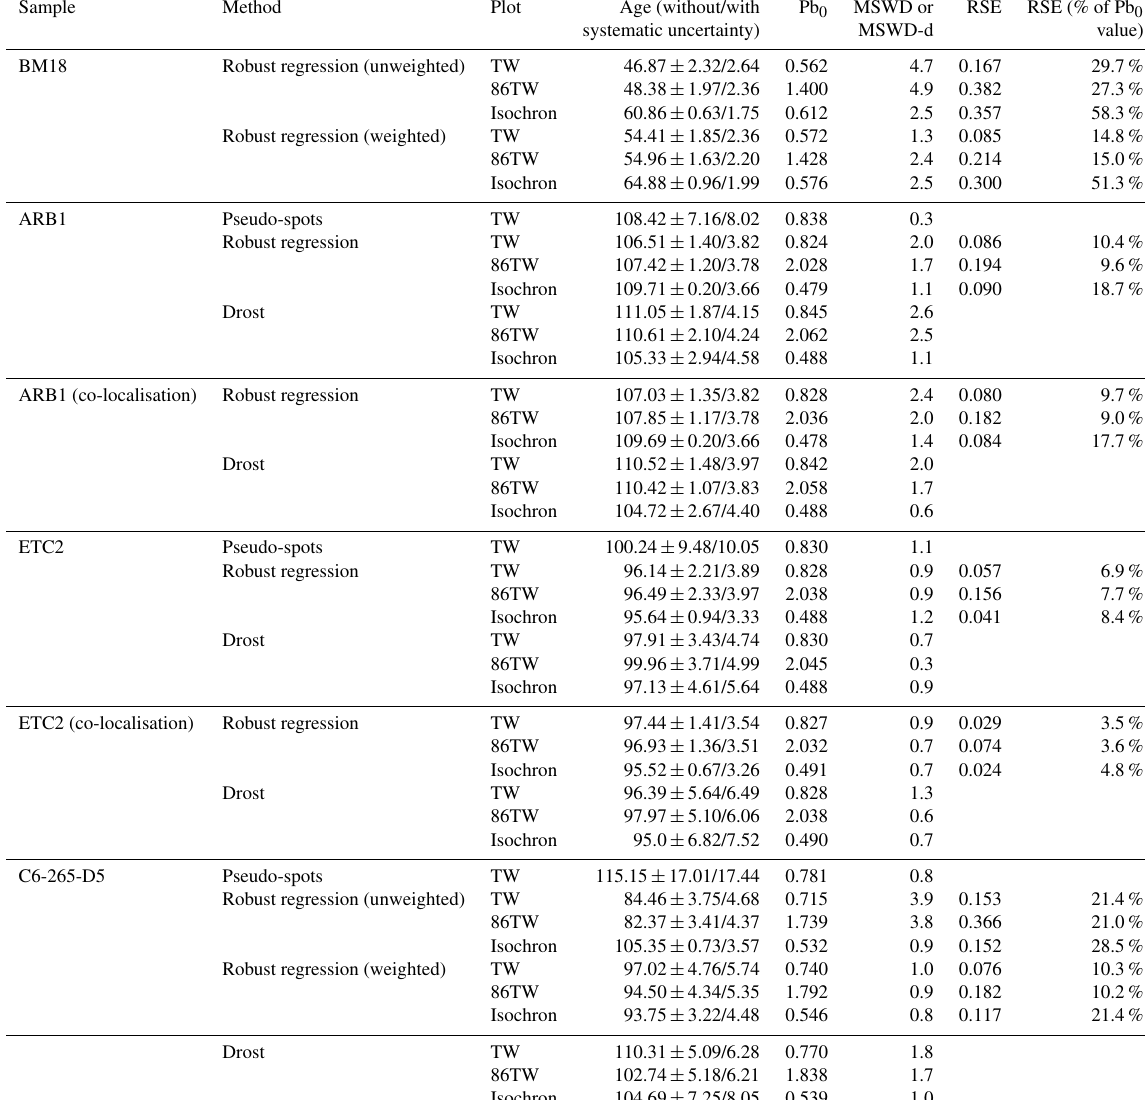
ting the isotopic maps in pseudo-spots allows for the calcu- lation of ages of 61.3 ± 3.0 Ma (Fig. 3e) and 61.7 ± 3.0 Ma (Fig. S3), with a MSWD of 0.1 and 0.4 respectively, which are values that are fully consistent with the ages obtained with the robust regressions from the entire maps (Table 1). The latter vary between 60.7 ± 2.0 Ma and 61.8 ± 2.2 Ma ac- cording to the diagrams considered (Fig. 3c, d; only TW concordia plots shown). They are identical within the limits of uncertainty to the values obtained with LA-ICP-MS spot analysis, both by Beaudoin et al. (2018) and in our laboratory (63.2 ± 2.2 and 61.2 ± 2.9 Ma respectively; Fig. 3f). They are also similar to the ages calculated by using the approach of Drost et al. (2018) (60.8 ± 2.1 to 61.4 ± 2.1 Ma according